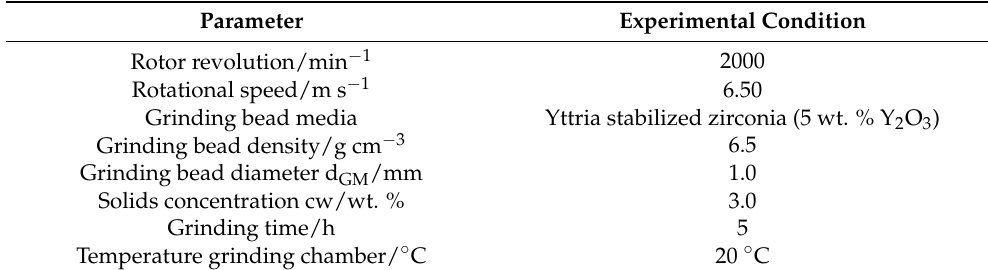
Table 3. Overview of the set of parameters defining the standard experimental conditions for the glass flake